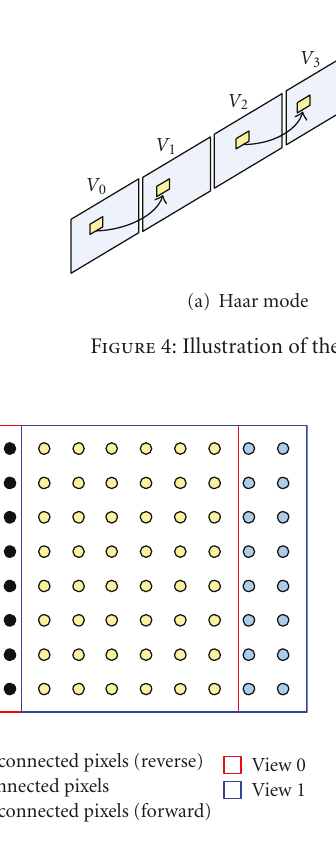
Figure 5: The example shown the unconnected, connected, and occluded pixels, when we consider image view 0 and 1 (reference view).